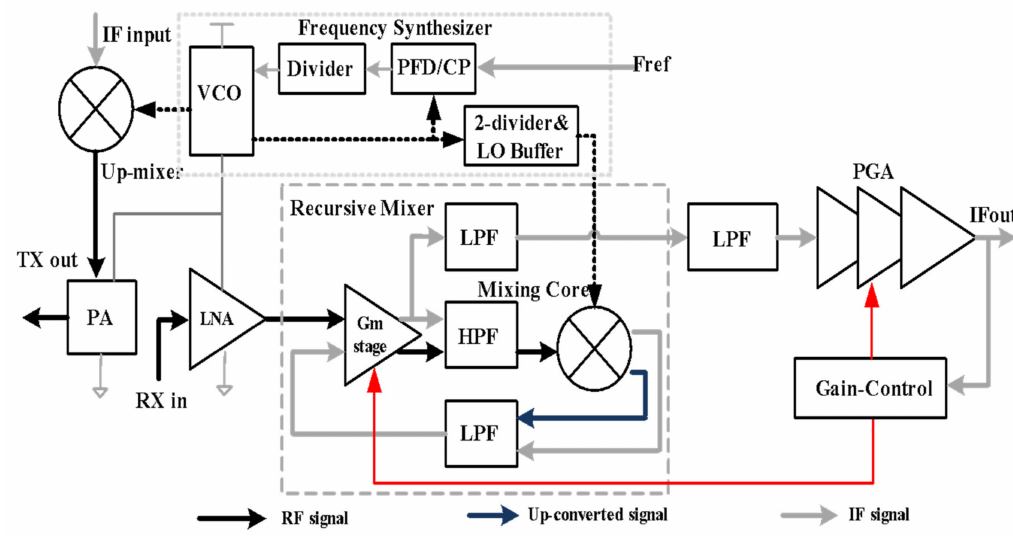
Figure 1. The system topology of the proposed recursive